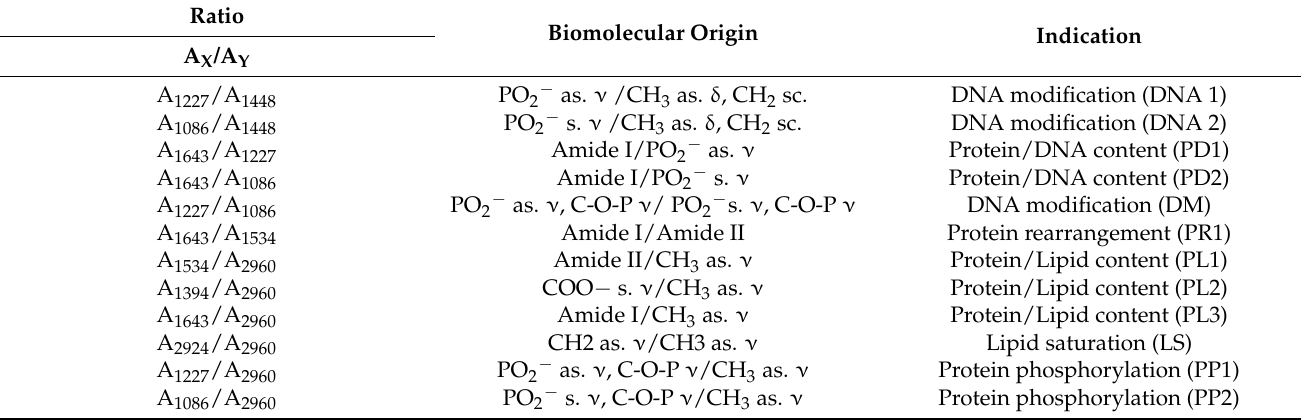
Table 1. A x /A y indicate the ratio between the absorbances of selected band [35,40–43]; abbreviation: as = asymmetric, s = symmetric, ν = stretching, δ = bending, sc =